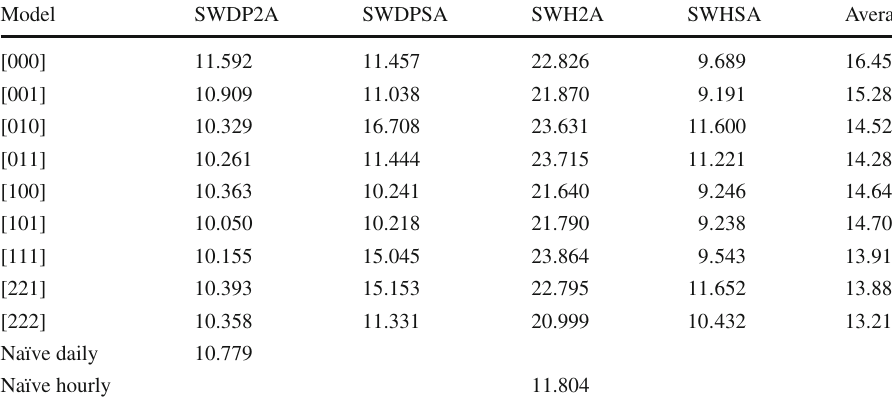
Table 1 Comparison of ARIMA models in terms of Avg.